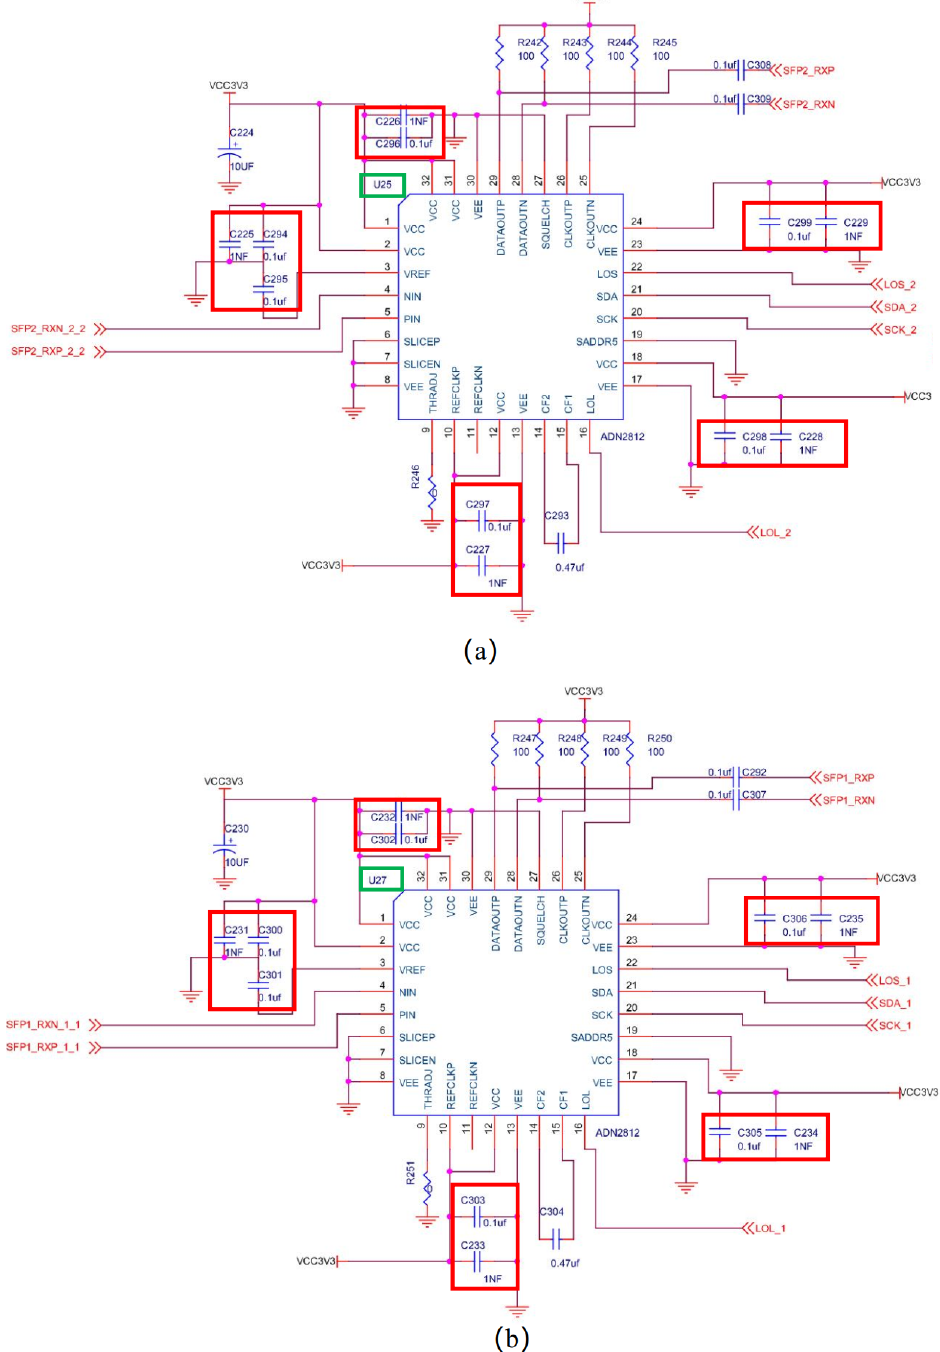
Figure 2. Repetitive pattern. Panels ( a , b ) are two of the same IC modules from a single netlist, U25 and U27, in green blocks. The capacitors in red blocks between the power net and GND net are scattered, and would be allocated equally by IC module matching in Section